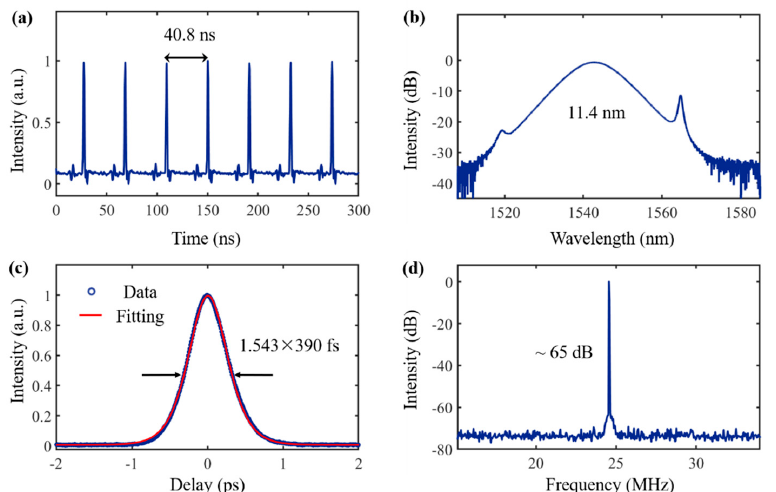
Figure 5. Pulsed output performance of WSe 2 -SA-based erbium-doped mode-locked fiber laser ( a ) typical pulse output sequence with a time interval of 40.8 ns; ( b ) spectrum with a center wavelength of 1552.68 nm and a 3 dB bandwidth of 11.4 nm; ( c ) autocorrelation and sech 2 fit of the output pulse with a pulse width of 390 fs; ( d ) RF spectrum with ~65 dB signal-to-noise ratio.